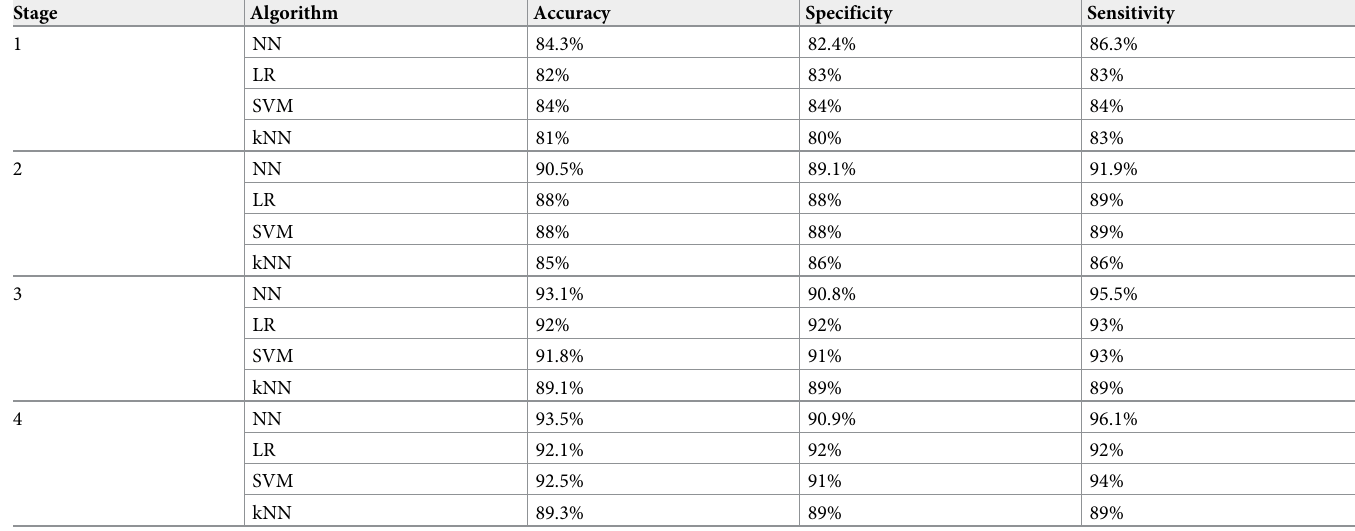
Table 3. Accuracy, specificity and sensitivity obtained by the Neural Network (NN), Logistic Regression (LR), Support Vector Machine (SVM) and k-Nearest Neigh- bors (kNN) algorithms, for each of the four clinical stages.